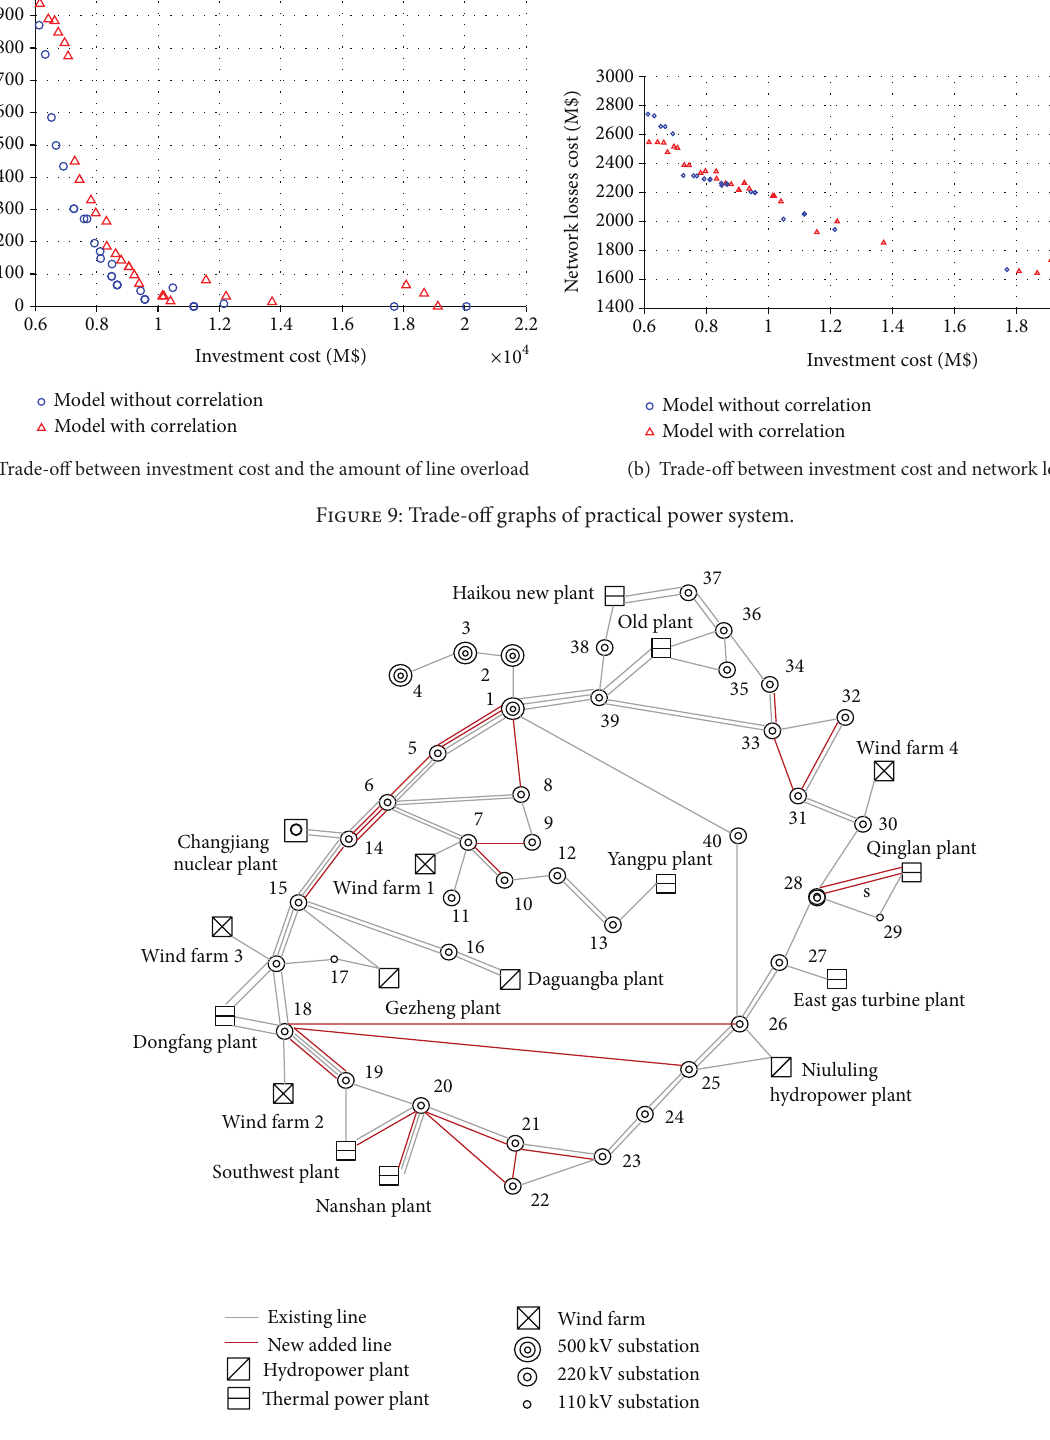
Figure 10: Final planning scheme of real power